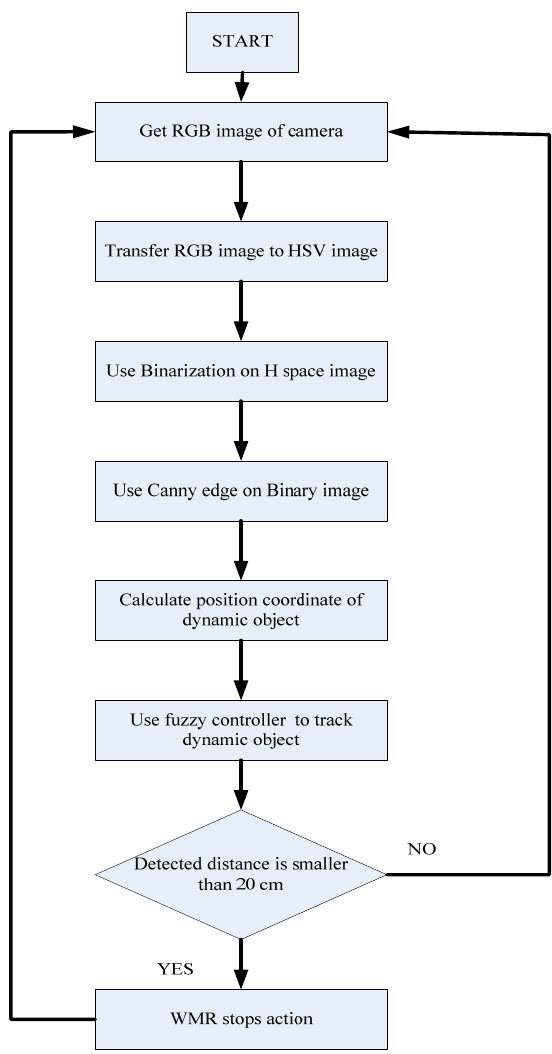
Figure 6. The flowchart of dynamic tracking.